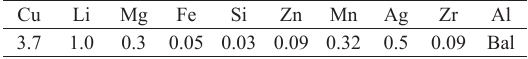
Table 1. Chemical composition of parent metal (%wt.).